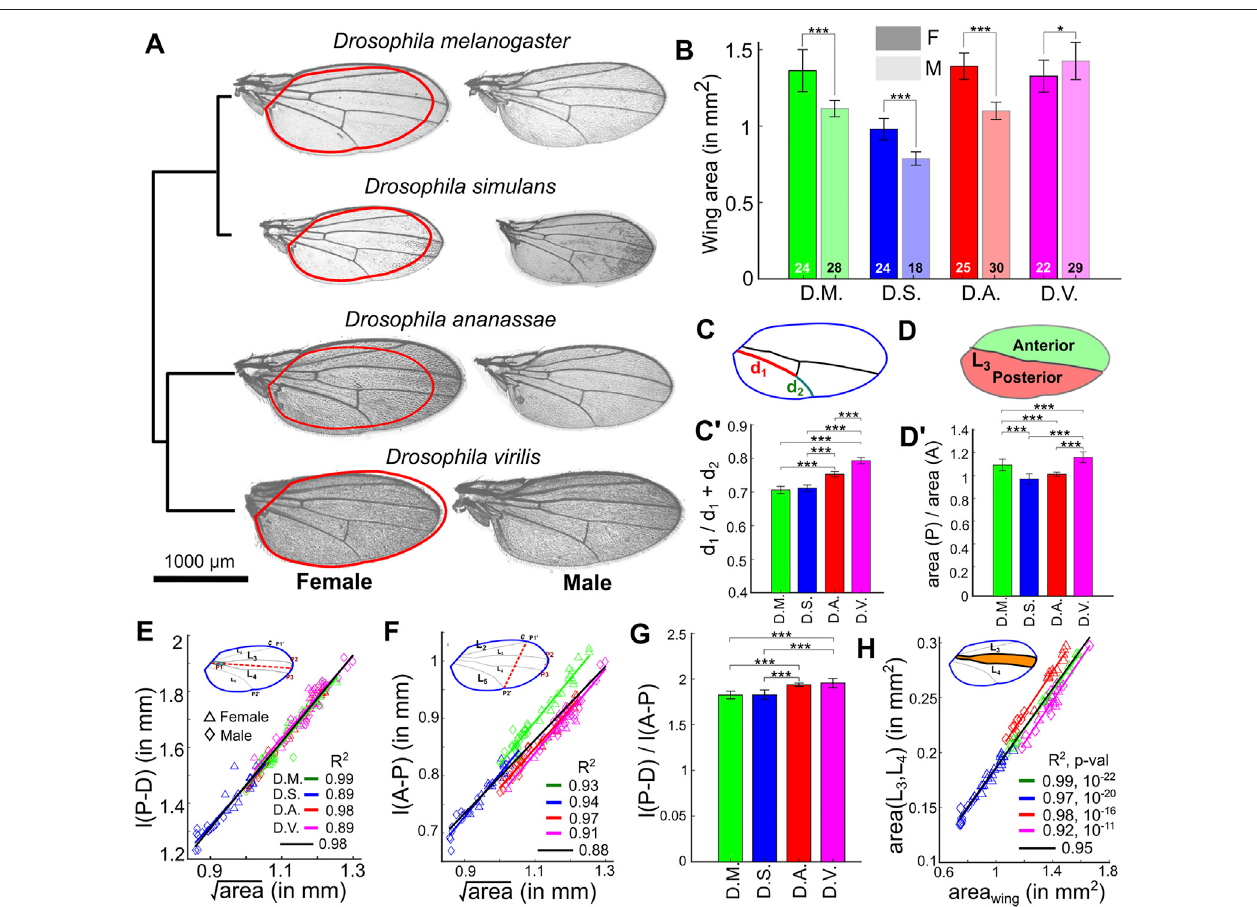
FIGURE 7 | MAPPER identi fi es differences in wing size and scaling relationships across Drosophila species. (A) Representative male (right) and female (left) wings forfourdifferentspecies.Redcontoursonfemalewingsrepresent theoutlineofthecorrespondingmalewing.Thedendrogram intheleftisrepresentativeofhierarchical clustering based on different features extracted using the pipeline. (B) Quanti fi cation of wing areas by MAPPER for wings from different species and different sexes. (C-C ’ ) Quanti fi cation of shift in posterior cross vein position in female wings (d 1 is de fi ned as the segment of L 5 from the proximal end of the vein to posterior cross vein,d 2 isde fi nedasthesegmentofL 5 fromtheposteriorcrossveintothedistalendofL 5 ). (D-D ’ ) Relativeanterior(A)andposterior(P)areasinfemalewings. (E) Scaling relationships between the length of the proximal-distal [l (P-D)] axis and the overall wing blade area for the various species. Legends for different sexes have been included.Straightlineswere fi ttoestimatetheexistenceofscalingrelationshipsforthefourspecies. (F) Scalingrelationshipsbetweenthelengthoftheanterior-posterior [l(A-P)]axisandtheoverallwingbladeareaforthefourspecies. (G) Thel(P-D)tol(A-P)ratioforfemalesfromdifferentspecies. (H) Scalingrelationshipsbetweenthearea of theintervein region between veins L 3 -L 4 and the overall wingblade areafor thefour species. Straightlines were fi t toestimate the existence ofscaling relationships for the different species. (* p < 0.05, ** p < 0.01, *** p < 0.001).